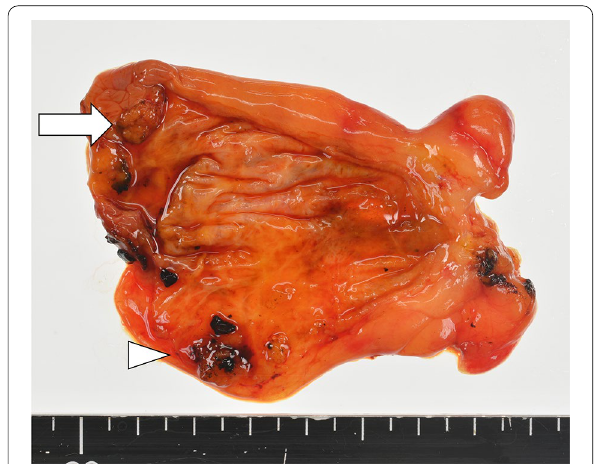
Fig.2 Macroscopic findings showed papillary tumor in the fundus of gallbladder (arrow). Some gallstones existed within the gallbladder